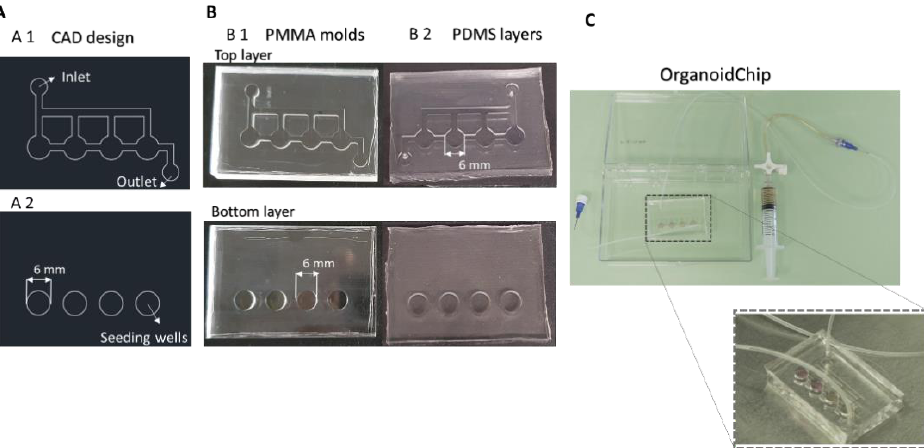
Figure 2. Design and fabrication of the organoid on-chip device. ( A ) AutoCAD design of the OrganoidChip ( A1 ) top and ( A2 ) bottom layers. The top layer includes one inlet channel distributed in four small channels and one outlet. The bottom layer consists of four round wells of 6 mm in diameter for organoids’ seeding and growing. ( B ) OrganoidChip poly(methyl methacrylate) (PMMA) layers mold fabricated in ( B1 ) the milling machine and the ( B2 ) respective polydimethylsiloxane (PDMS) layers. ( C ) OrganoidChip setup.